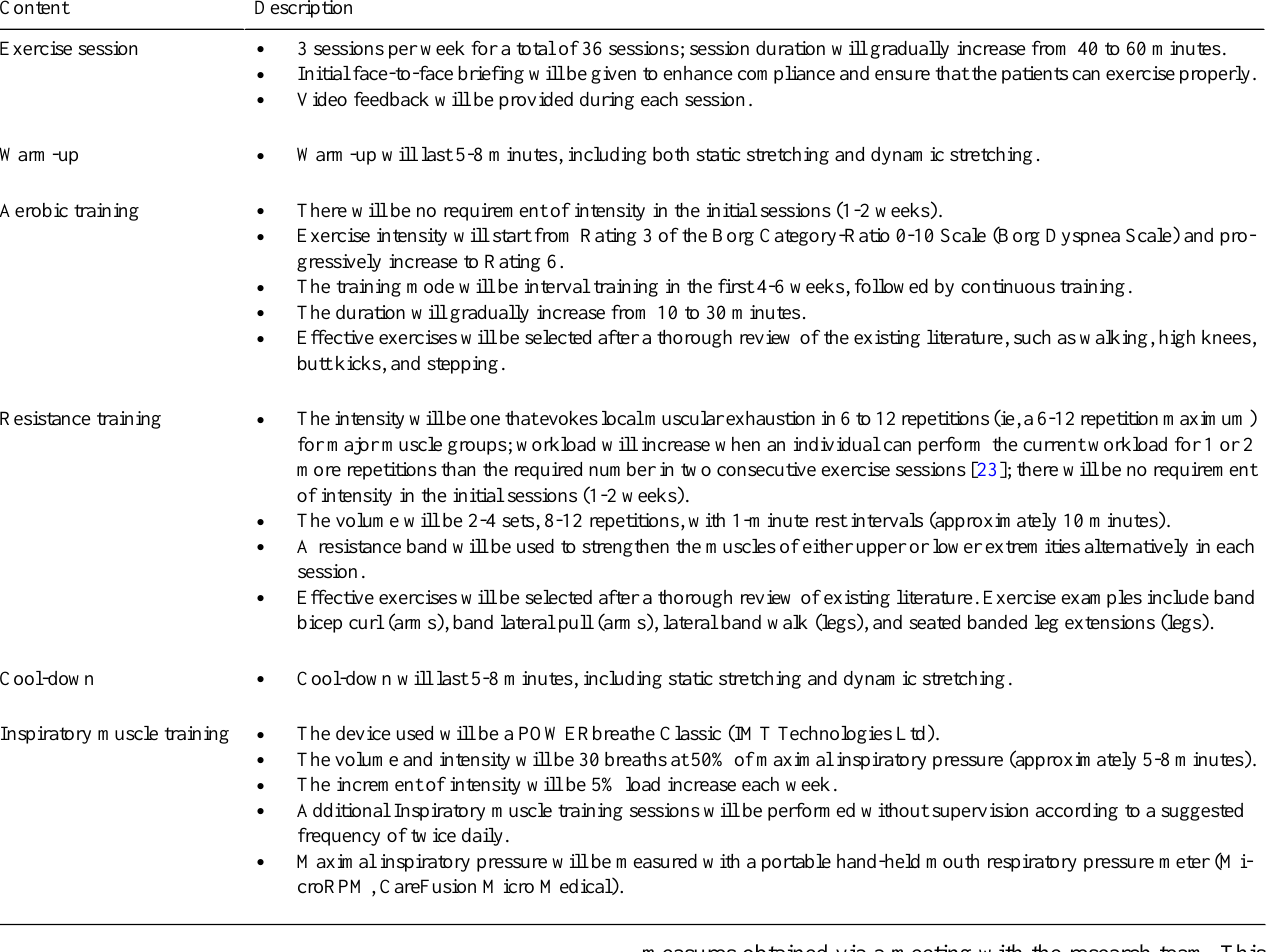
Table 1. Description of the cardiorespiratory exercise intervention (exercise